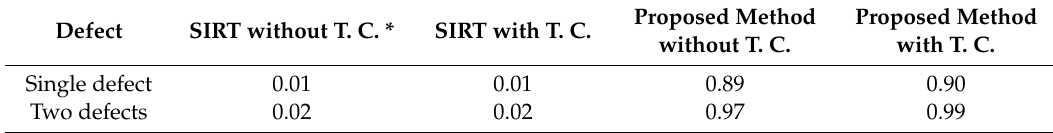
Table 2. Computation times of SIRT and our method (UNITS: s). Defect SIRT without T. C.